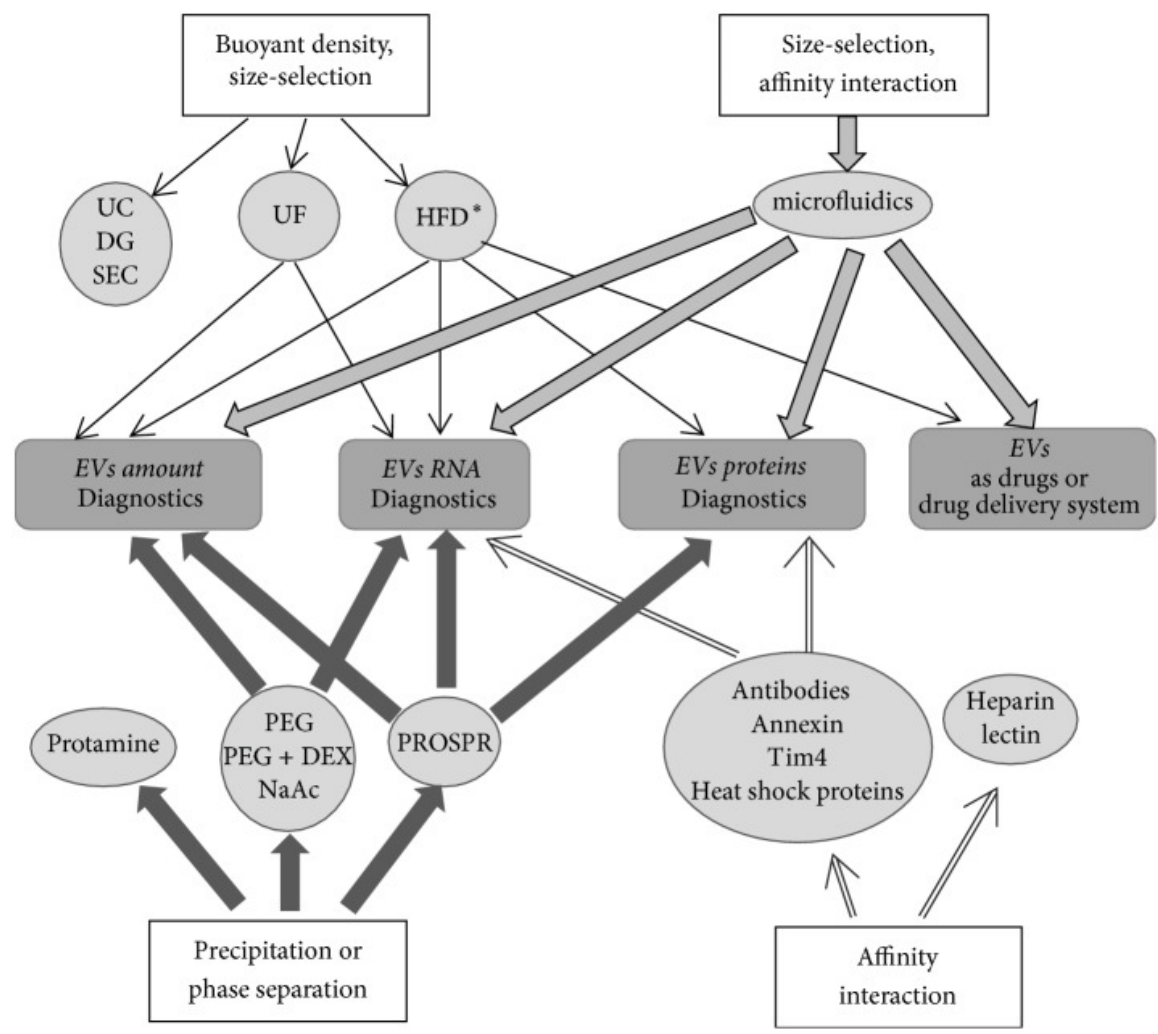
Figure 3. Commonly employed methods for exosome isolation and their downstream applications. Several methods developed to date for exosome isolation are based upon their buoyant density, Scheme 1, 13 and 1.19 g/mL, the ultracentrifugation method (UC) was further refined to isolate pure preparations of exosomes based upon their buoyant density by isopycnic ultracentrifugation over